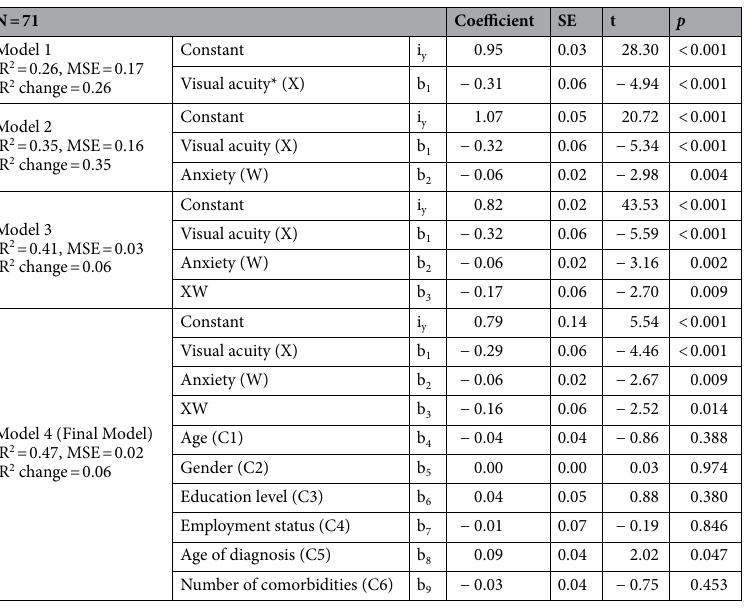
Table 4. Stepwise moderation analysis with anxiety (W) as moderator of the relationship between visual acuity (X) and quality of life (Y). *Presenting distance visual acuity in the better eye (logMar values); categorical variables: gender (female; male); education level (up to 9 years of education; more than 9 years of education); employment status (full-time work; retirement); age of diagnosis (up to 1 year; more than 1 year); number of comorbidities (up to 1; 2 or more).